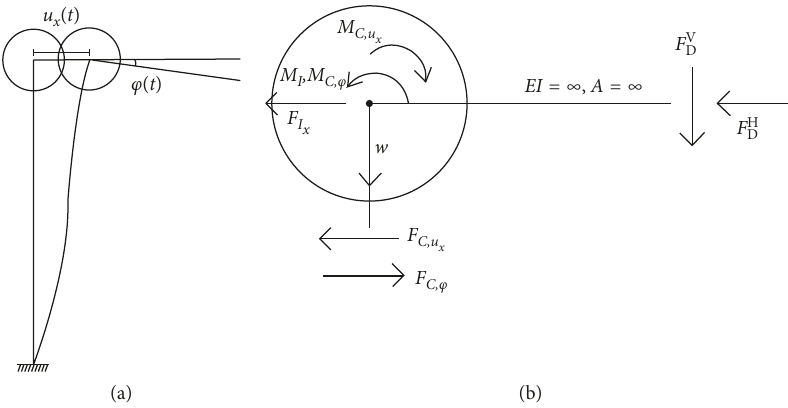
Figure 10: The 2-DOF lumped-mass mechanical model (a) and its free body diagram (b).